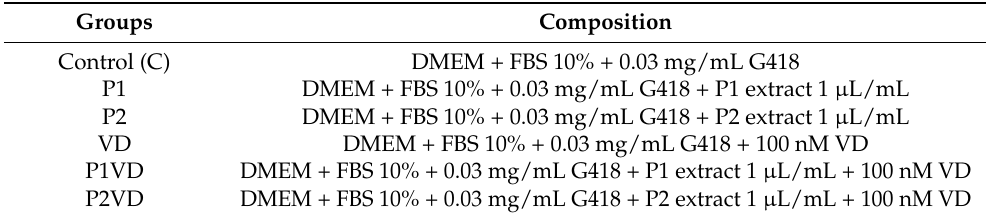
Table 2. Composition of all treatment groups. Groups